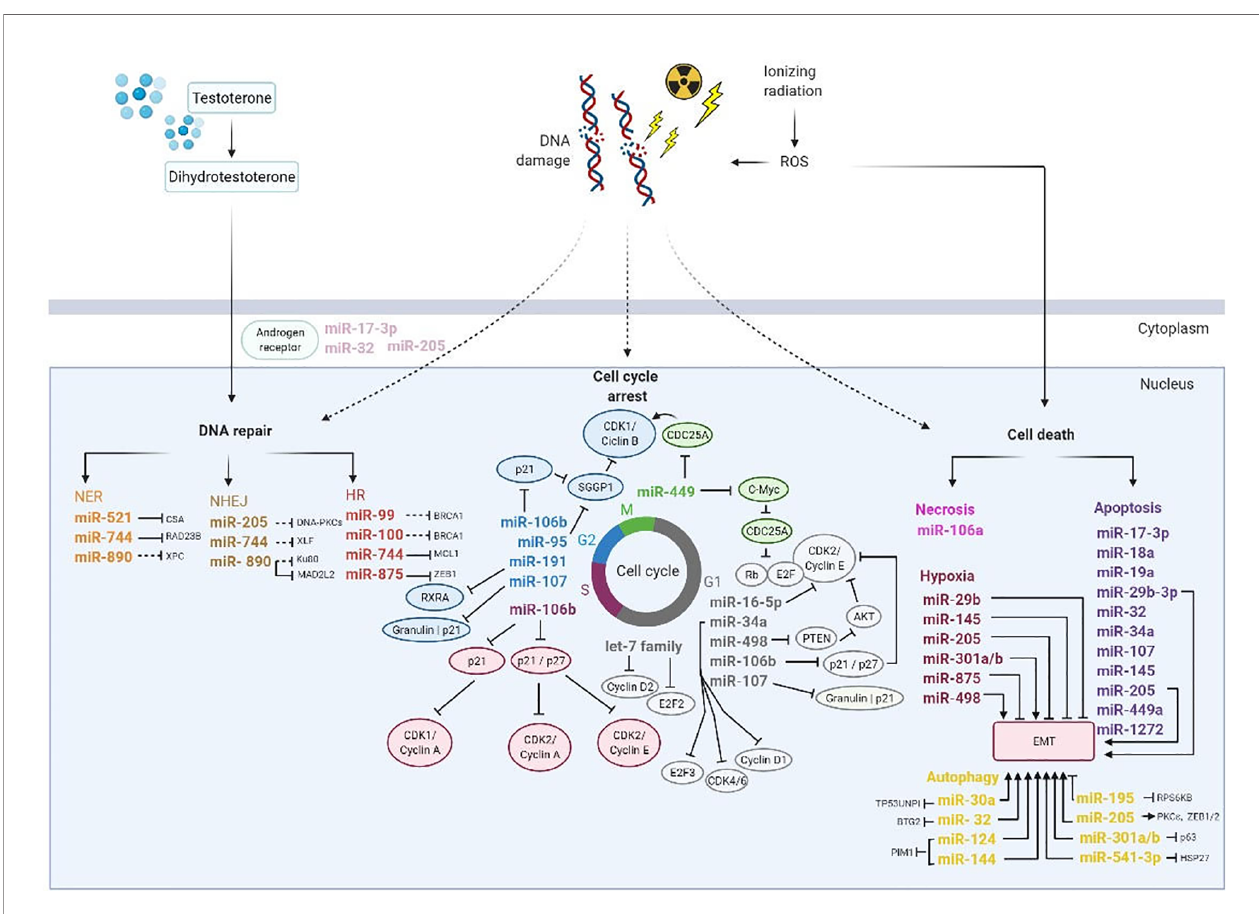
FIGURE 6 | Overview of miRNAs involved on DNA damage repair, cell cycle arrest, and cell death induced by ionizing radiation. Thus, photon beams cause DNA damage directly or indirectly by reactive oxygen species (ROS). In order to repair DNA damage, the cell activate DNA damage response pathways including nucleotide excision repair (NER), non-homologous end joining (NHEJ) and homologous recombination (HR). Additionally, miRNAs regulated cell cycle progression to allow DNA damage repair and depends on cyclin dependent kinases (CDKs), cyclins and transcription factors family EF2. Also, miRNAs are in fl uenced by several factors in the tumor microenvironment such as hypoxia and epithelial mesenchymal transition (EMT) and play an important role in biological processes as apoptosis and autophagy. Consequently, hypoxia promotes DNA repair by transcription of the androgen receptor expression. AKT, Protein kinase B; CDC25A, Cell division cycle 25 A; G1 and G2, transition phases of the cell cycle; HSP27, Heat shock protein 27; M, Mitosis; PTEN, Phosphatase and TENsin homolog; Rb, Retinoblastoma protein; RXRA, Retinoid X receptor alpha; S, phase S; SGGP1, Sphingosine-1-phosphate phosphatase 1. Black inhibition line displays direct targeting; black dashed- inhibition line displays indirect targeting; arrow display an induction of tumor